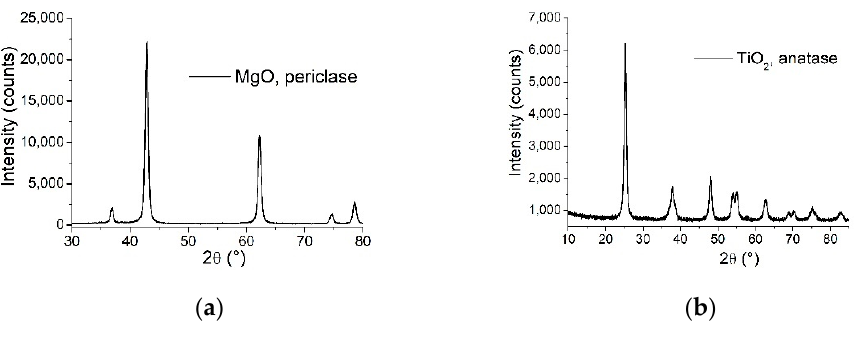
Figure 1. SEM images of powders: ( a ) MgO and ( b ) TiO 2 .